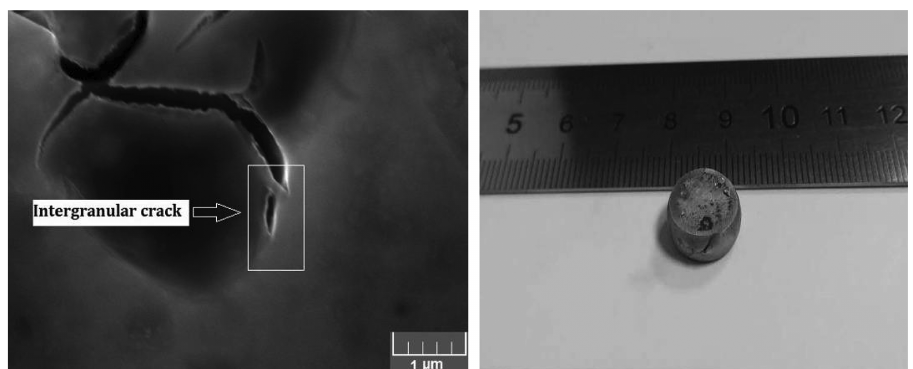
Figure 10: 3D energy dissipation maps at different strains, temperatures and strain rates: (a) at strain of 0.02, 0.04, 0.06, 0.08, 0.1, 0.2, 0.3, 0.4, 0.5, 0.6, 0.7, 0.8 and 0.9; (b) at temperature of 523, 573, 623, 673, 773 and 823 K; and (c) at strain rate of 0.005, 0.01, 0.1, 1, 5 and 10s − 1 .